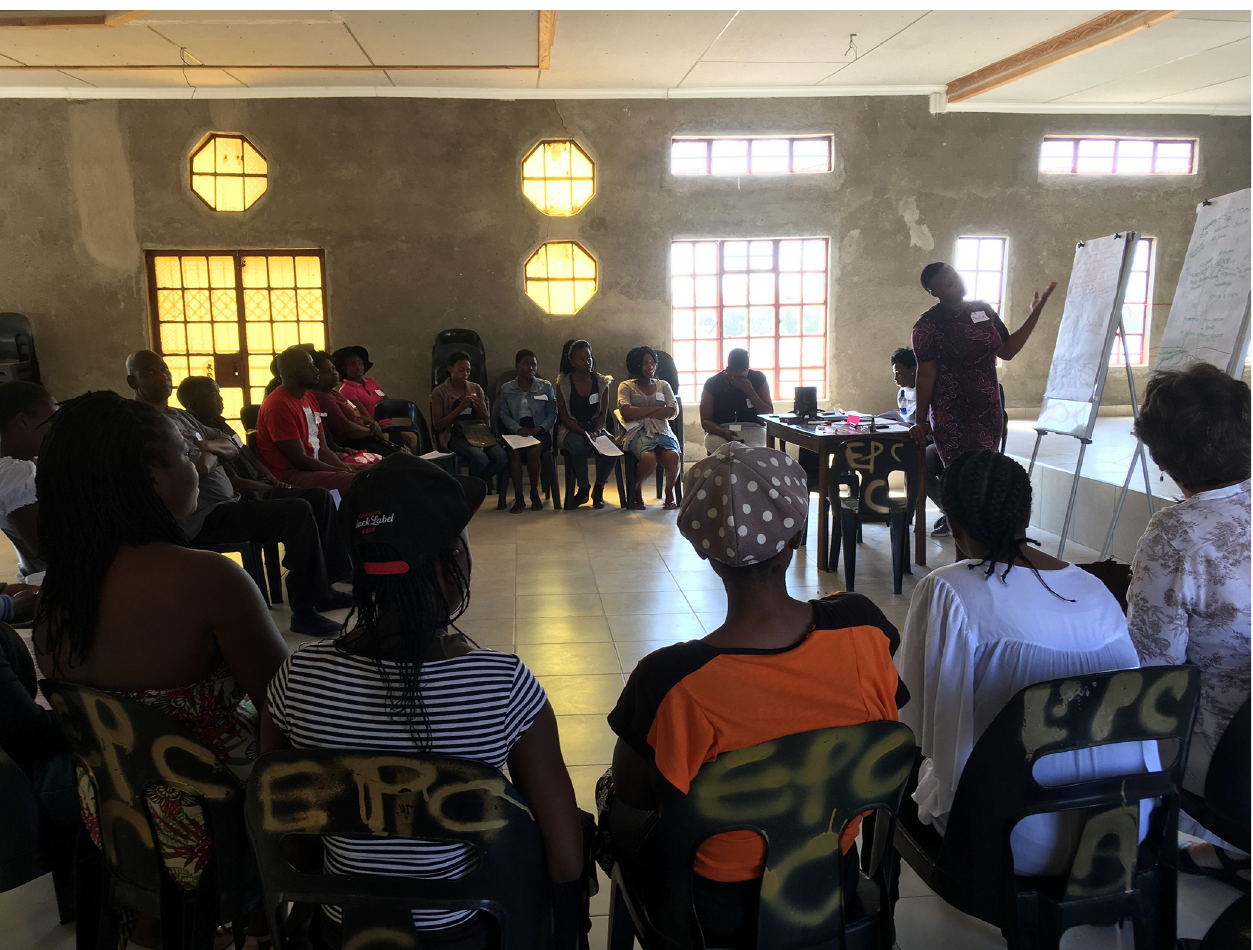
Fig 3. Community stakeholder facilitating a group discussion on AOD abuse as a priority local health concern. Image owned by the VAPAR programme and reproduced with permission in this paper under a creative commons license. Permissions have been secured from participants for the reproduction of all images taken during the course of the